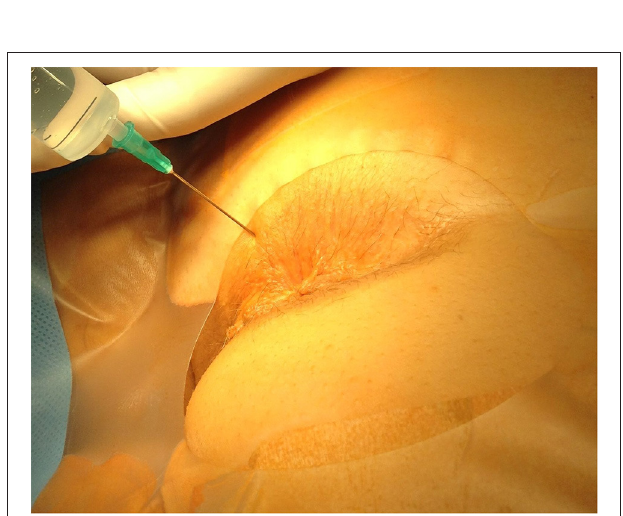
FIGURE 2 | Direction of the first injection.